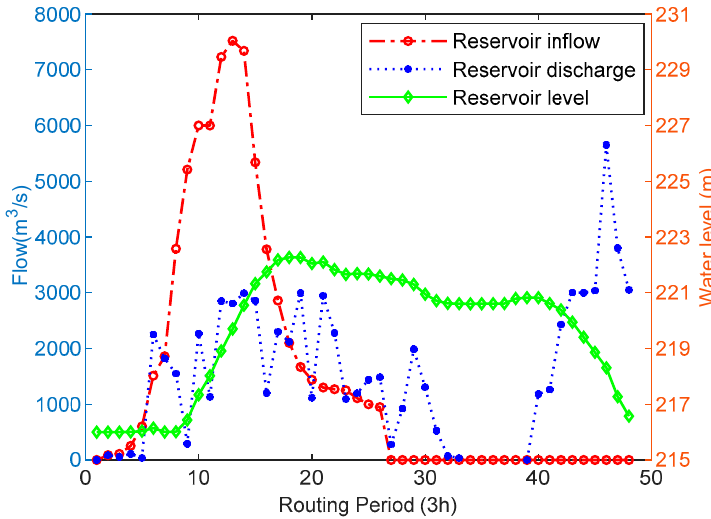
Figure 9. Operation process of Panjiakou Reservoir using ε -PSO.